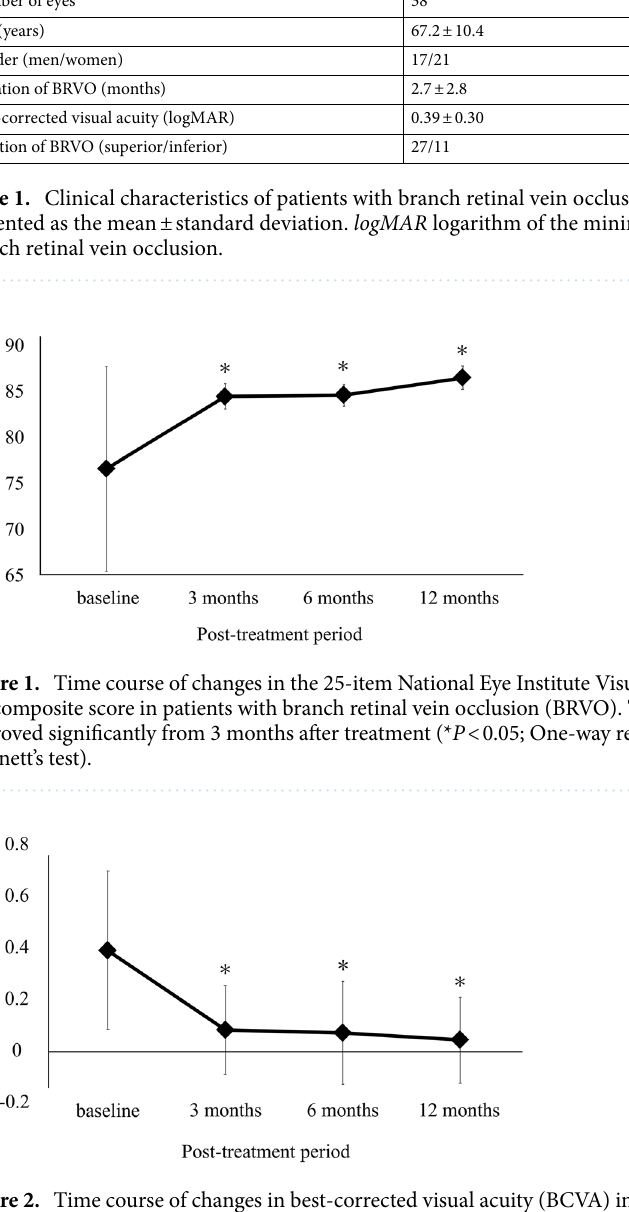
Figure 2. Time course of changes in best-corrected visual acuity (BCVA) in patients with BRVO. BCVA improved significantly 3 months after treatment (* P < 0.05; One-way repeated analysis of variance with Dunnett’s